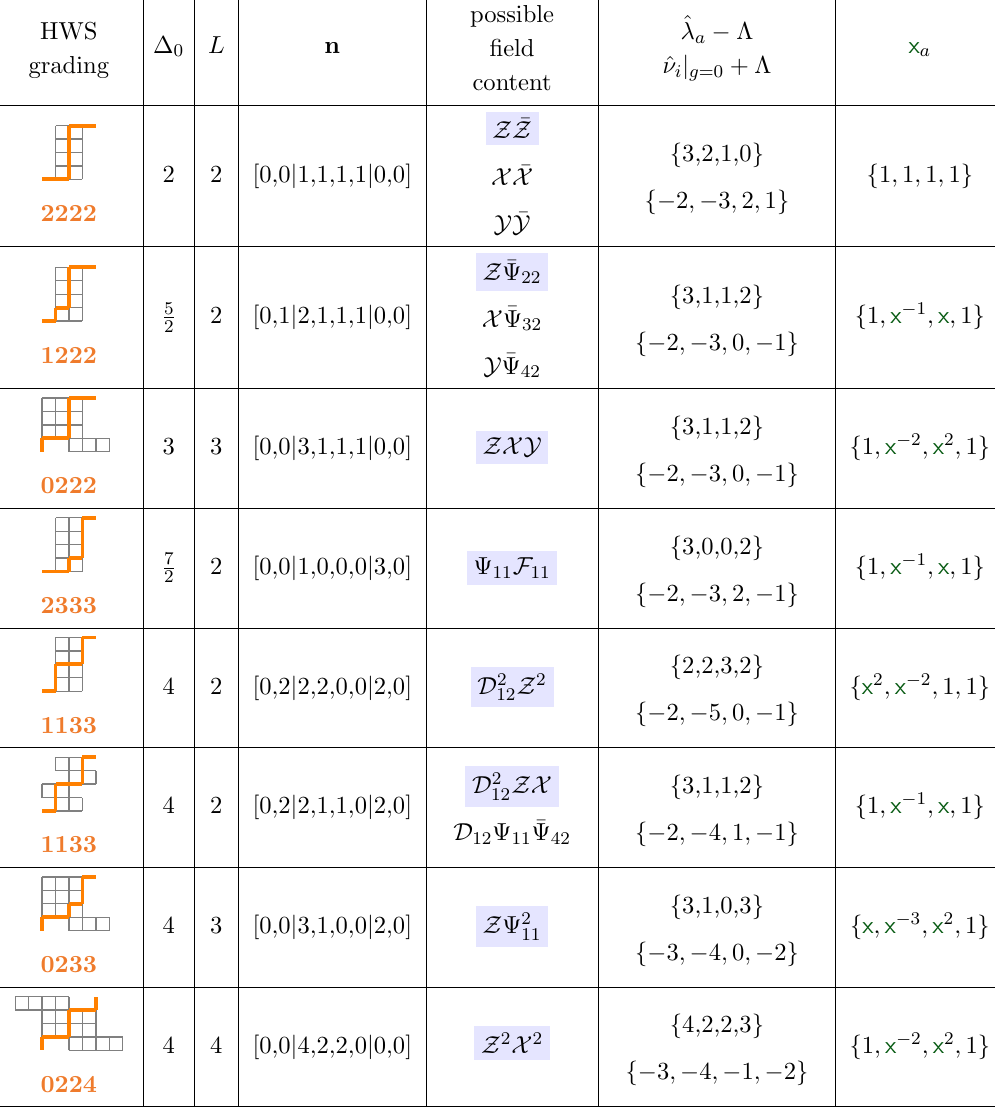
Table 1 . Representative operators from the submultiplets that we consider in this paper. We will refer to the operators by the highlighted examples listed in the possible (cid:12)eld content column. Note that this does not refer to the precise structure of the